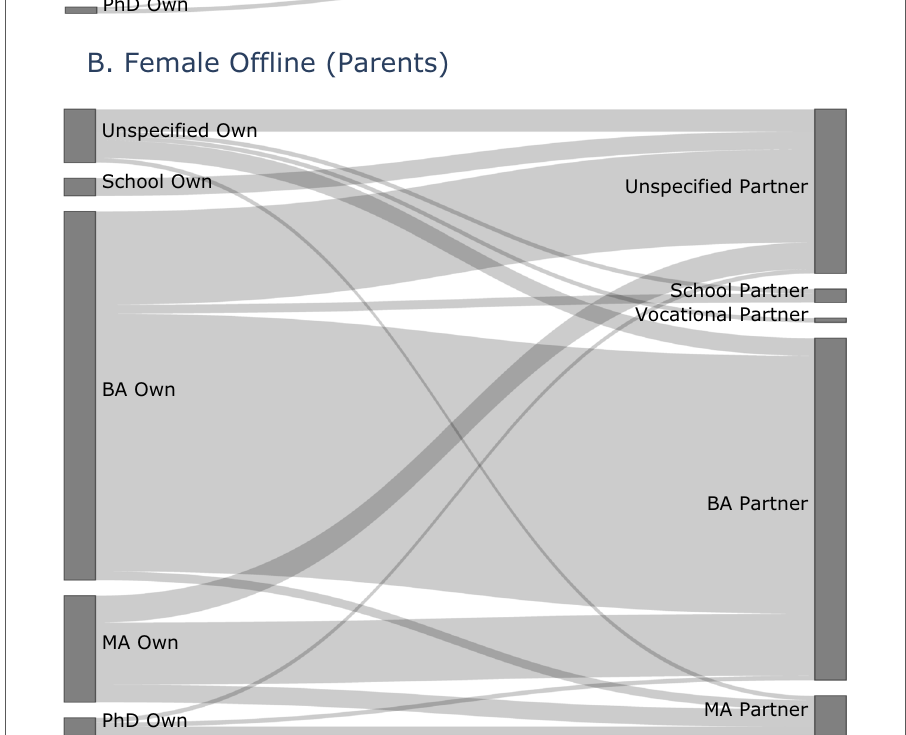
Fig. 3 Flow of female preferences from Own Education to desired Partner Education , including those who did not specify either of these